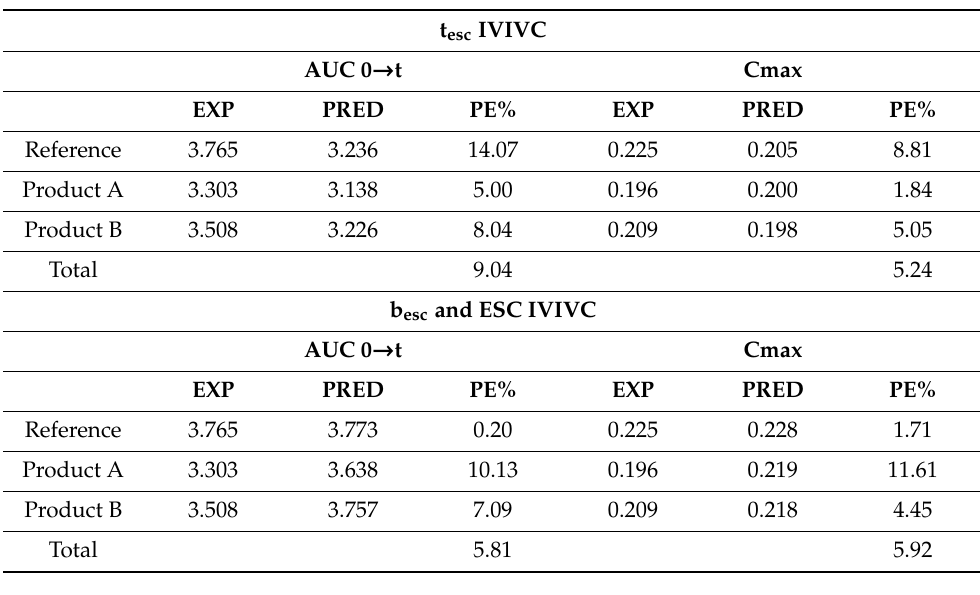
Figure 12. Experimental and predicted candesartan plasma profiles for the three studied formulations using the t esc one-step IVIVC and the b esc and ESC one-step IVIVC. C p = plasma concentration. Table 6. Prediction errors of Cmax and AUC values from the one-step in vitro–in vivo correlations.